Question: Give a one-sentence summary of this figure.
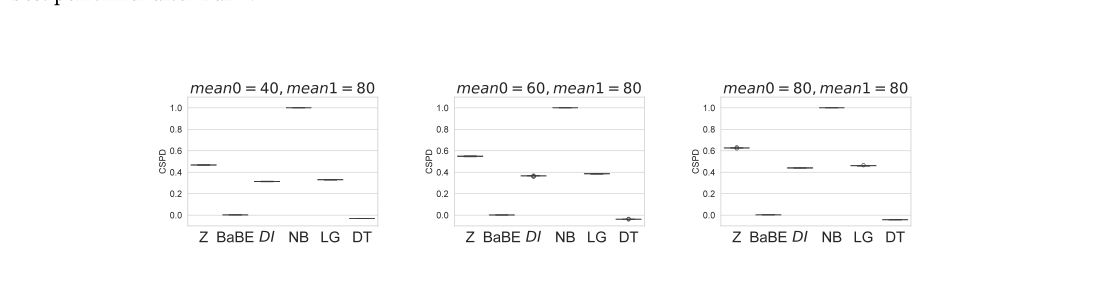
Answer: Experiments on the synthetic data sets: Conditional Statistical Parity Difference (CSPD). We recall that, for BaBE, DI, NB, LG and DT, the CSPD is defined as P[ ˆ𝑌ˆ𝐸= 1|𝐸,𝑆= 1] −P[ ˆ𝑌ˆ𝐸= 1|𝐸,𝑆= 0]. For 𝑍, the definition is similar, with ˆ𝑌ˆ𝐸replaced by 𝑌𝑍.